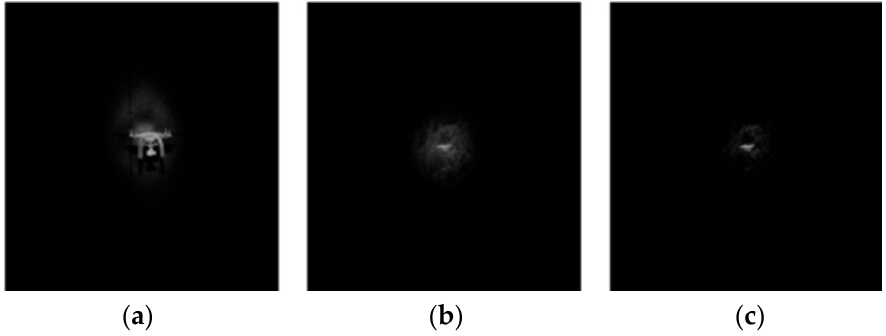
Figure 3. Real vs. simulated images. ( a ) Real image. ( b ) Coherent imaging image. ( c ) Incoherent imaging image.